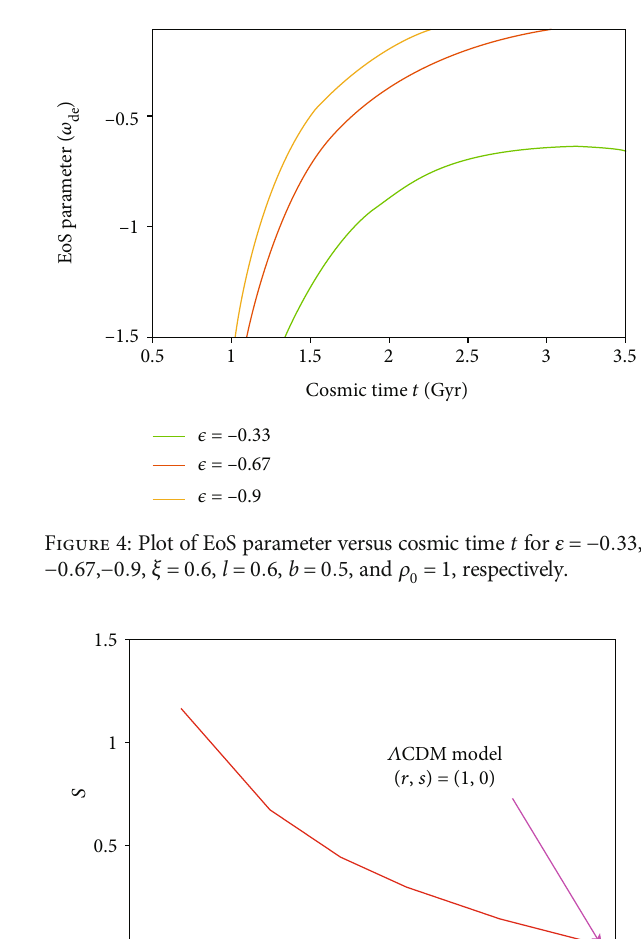
Figure 2: The plot of energy density ð ρ Þ of bulk viscous matter versus cosmic time t for ξ = 0 : 6 , l = 0 : 6 , ε = − 0 : 67 , b = 0 : 5 , and ρ = 1 , respectively. 0